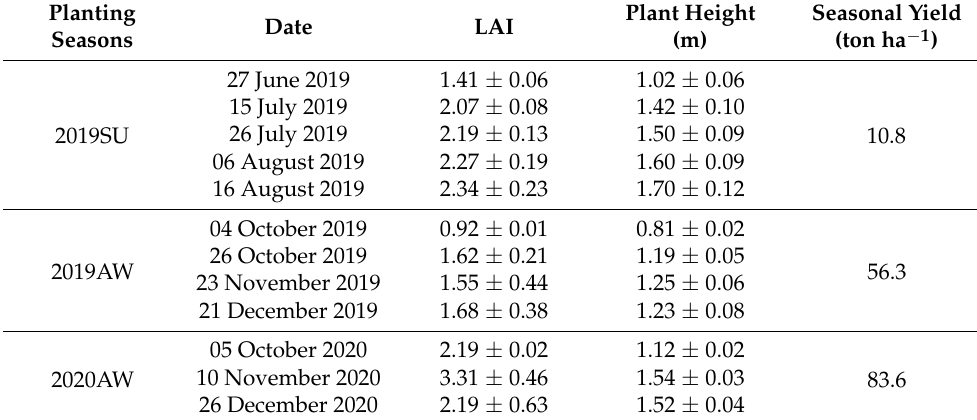
Table 1. Leaf area index (LAI), plant height, and total marketable fresh yield in each tomato growth season.